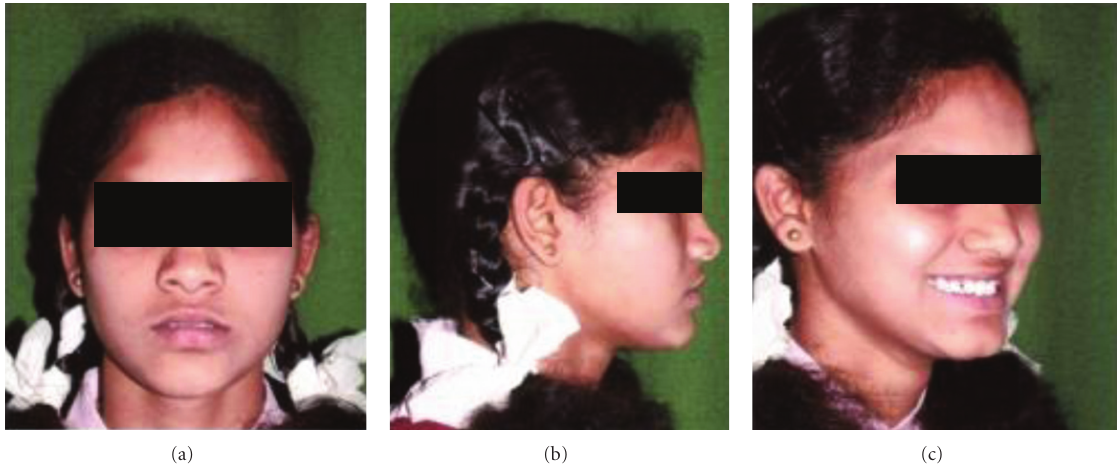
Figure 1: Profile of the patient showing straight profile with normodivergent growth pattern.